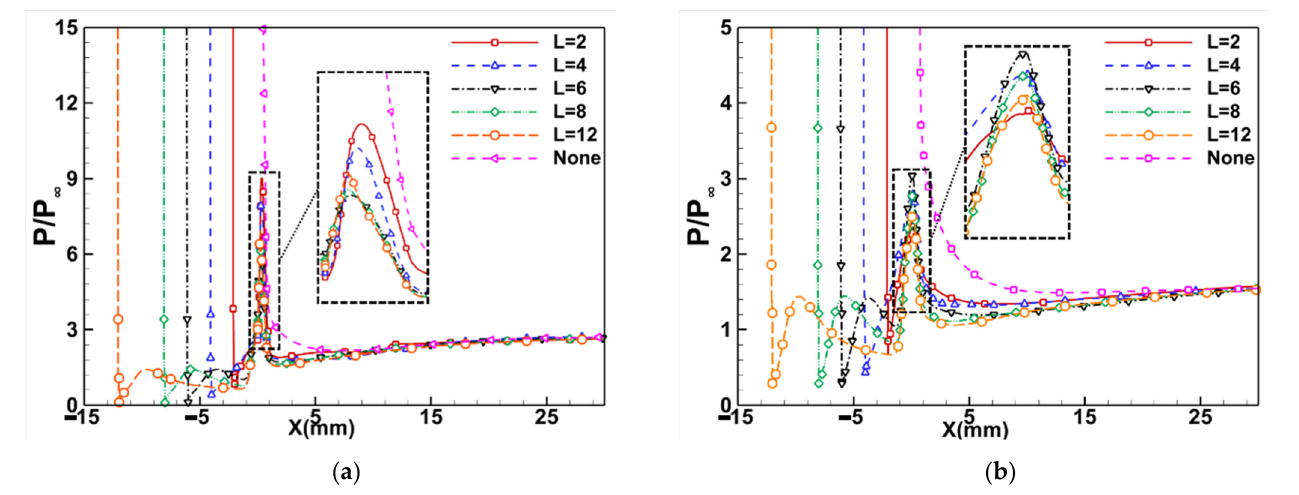
Figure 8. Comparison of streamlines over nosetip (left half: without aerodisk; right half: with aerodisk).